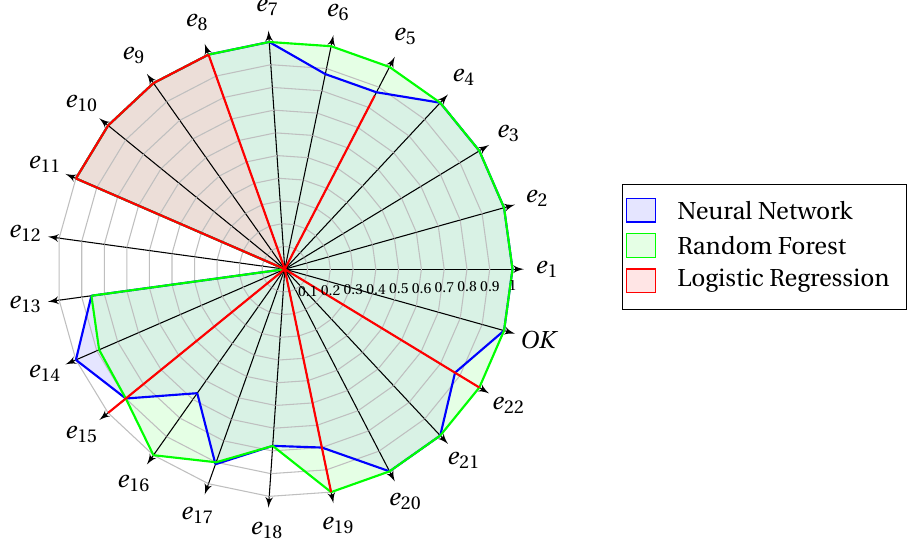
Figure 13. Comparison of the results of 3 applied methods machine learning in terms of accuracy.